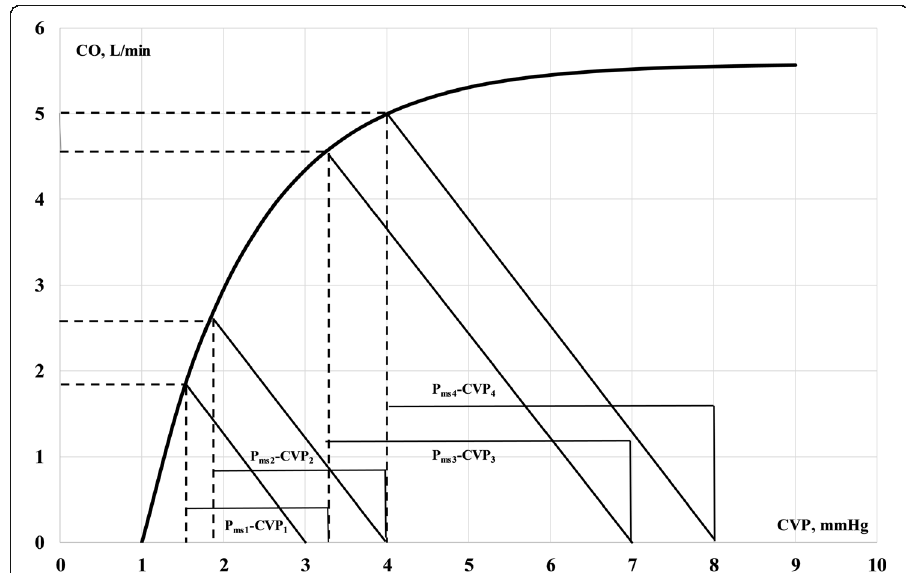
Fig. 1 Two situations of venous return curves intersecting with cardiac function curve after fluid resuscitation. CO is on y -axis and CVP is on x -axis. In the first situation, marked with subscripts 1 and 2, a volume bolus increases P msa from P msa1 to P msa2 and CVP from CVP 1 to CVP 2 . The increase in return pressure ( Δ ( P msa − CVP)) is large. Compare this favourable situation with the situation marked with subscripts 3 and 4: an identical increase in P msa generates a larger increase in CVP and thus a smaller Δ ( P msa − CVP). Relating Δ ( P msa − CVP) to Δ P msa ( E vol ) in the first instance yields a larger figure (app. 0.8) than in the second case (app. 0.25), indicating a better outcome of fluid resuscitation. This is formalised in Eq. (7). Heart efficiency, E h , declines from app. 0.5 – 0.6 in